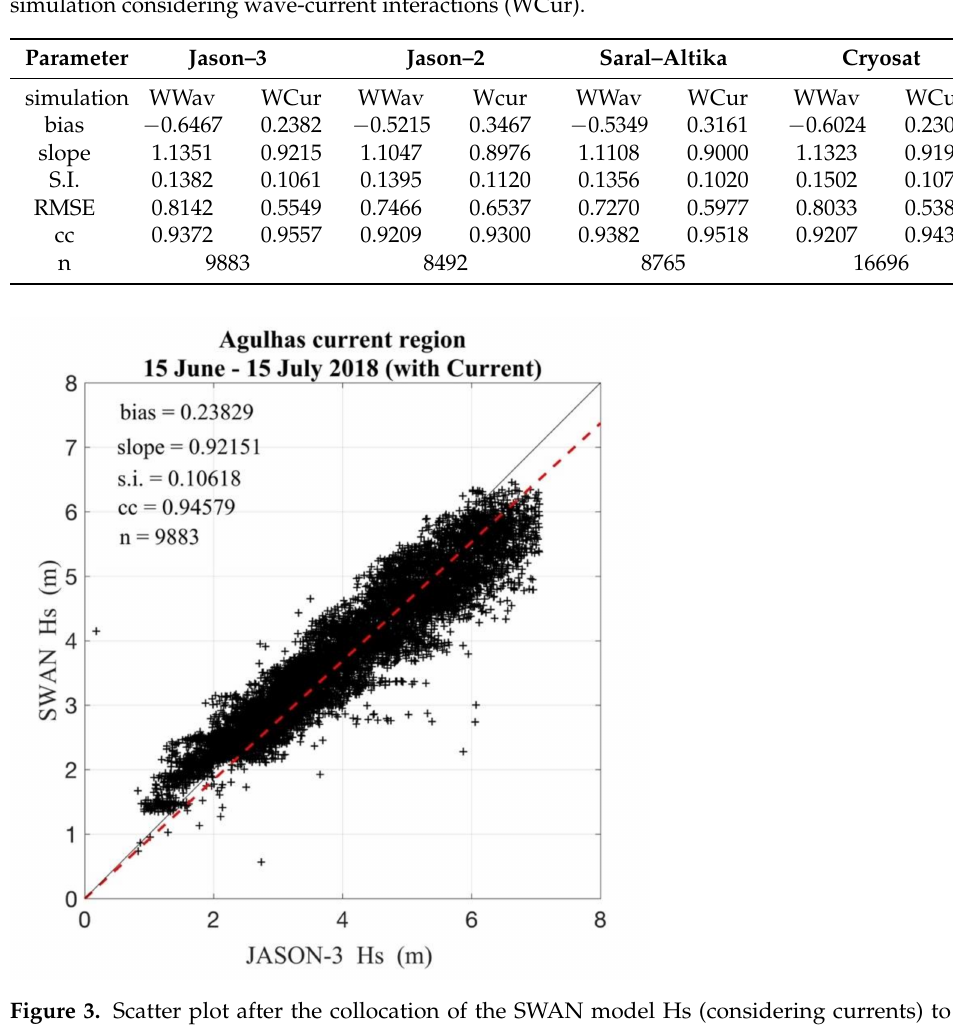
Table 2. Statistics for the Hs. S.I.—Scatter Index; cc—correlation coefficient, n—number of records. Bias, the best-fit scatter index and slopes between wave buoys observations and modelled Hs from SWAN. Left column-results from simulation without current (WWav); Right column—results from simulation considering wave-current interactions (WCur).